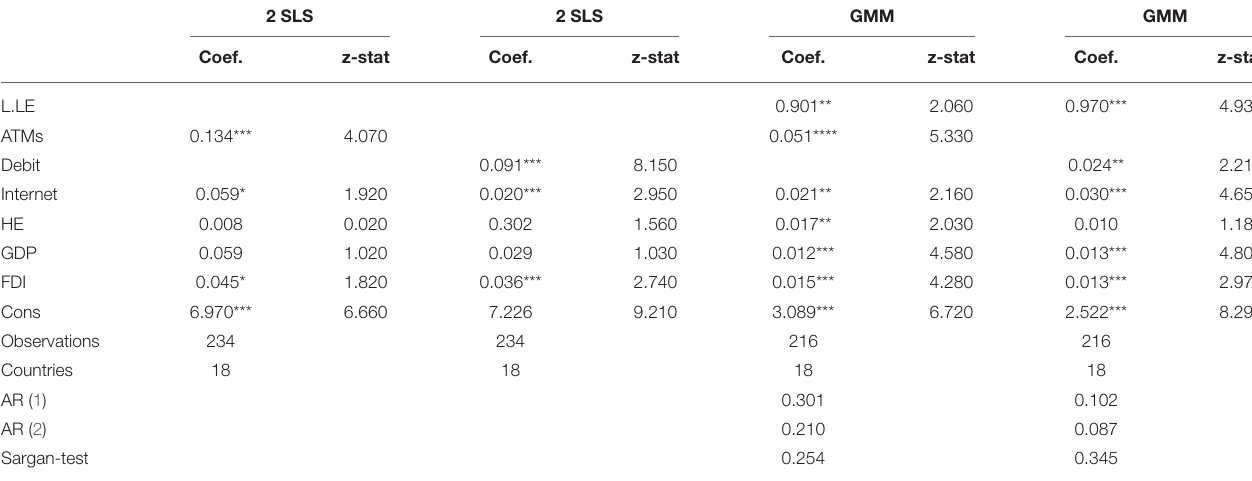
TABLE 4 | Financial inclusion and life expectancy (2 SLS & GMM).